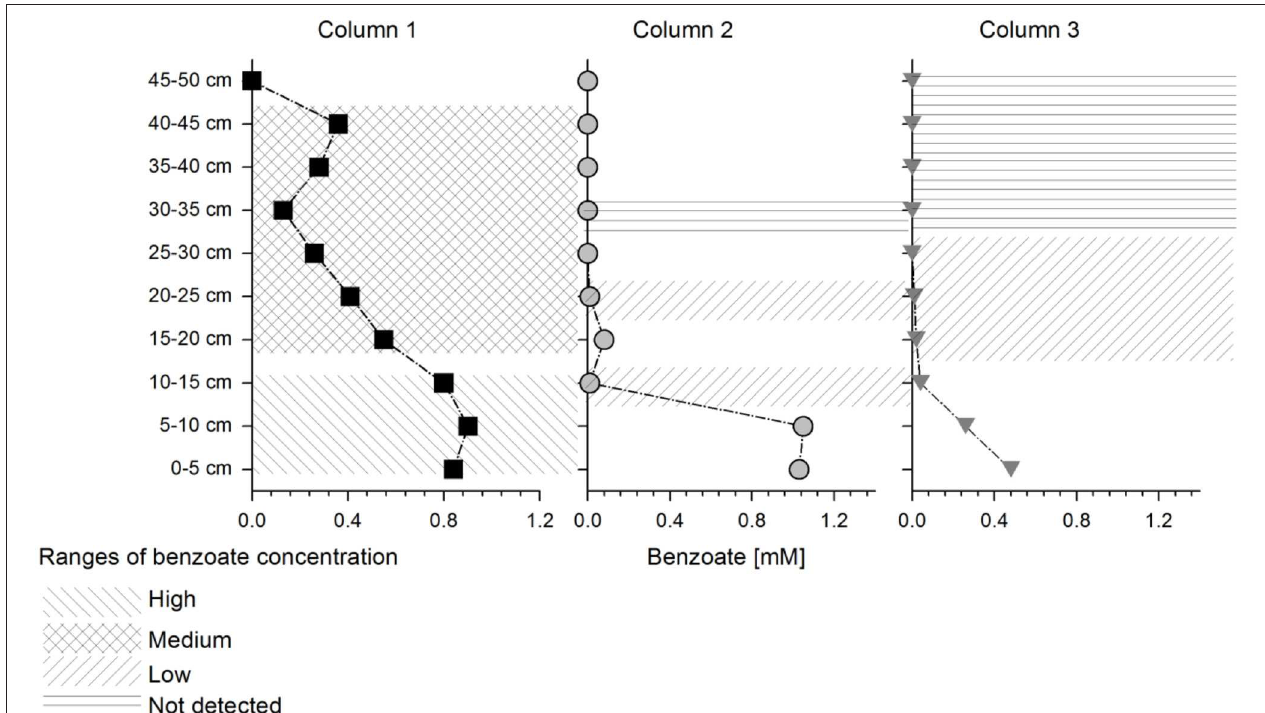
FIGURE 2 | Schematic representation of selected depths for statistical analysis: Different shaded areas on the columns represent different benzoate concentration ranges which were used further for the pairwise comparisons (as indicated in the legend). The columns are represented with the following symbols: columns 1 (squares), 2 (circles), and 3 (triangles),